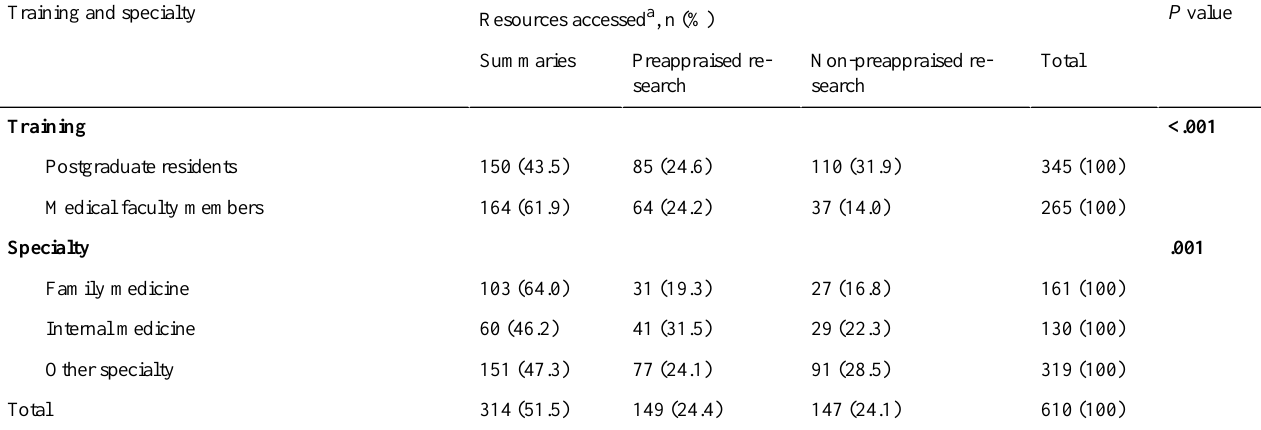
Table 5. Resources accessed across structured queries that led to at least one evidence resource.